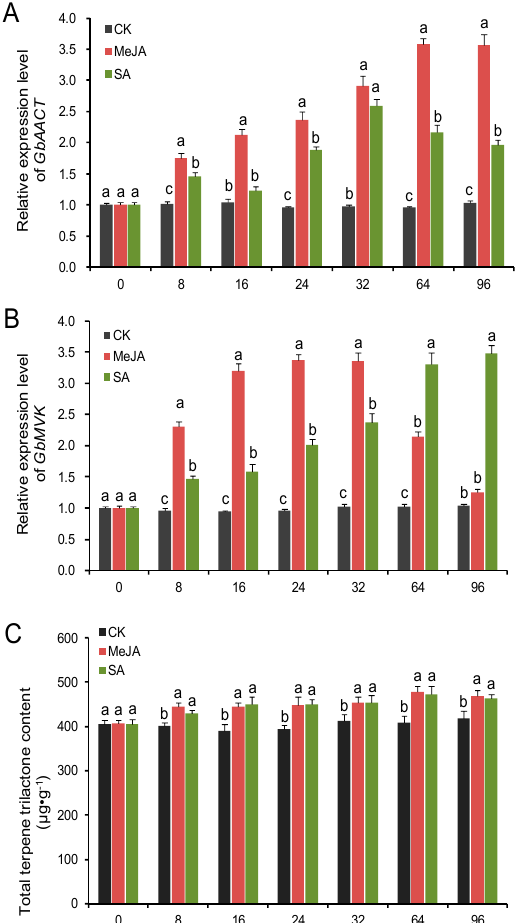
Figure 7. GbAACT and GbMVK expression level ( A , B ) and total terpene trilactone (TTL) content ( C ) changes in ginkgo by salicylic acid (SA) and methyl jasmonate (MeJA). The expression levels were normalized to the house-keeping gene GAPDH (glyceraldehyde-3-phospate dehydrogenase). Data from qRT-PCR were analyzed as expression ratios relative to the level of control (CK), and are shown as the mean ± SD of triplicate assays. Means with different letters from each time of post-treatments are significantly different at p < 0.05 by one-way ANOVA, with Tukey’s honestly significant difference test.